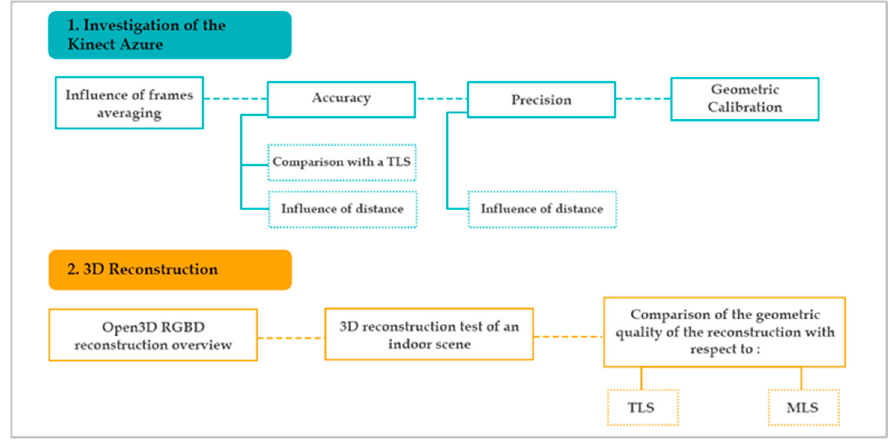
Figure 1. Overview of the general workflow.